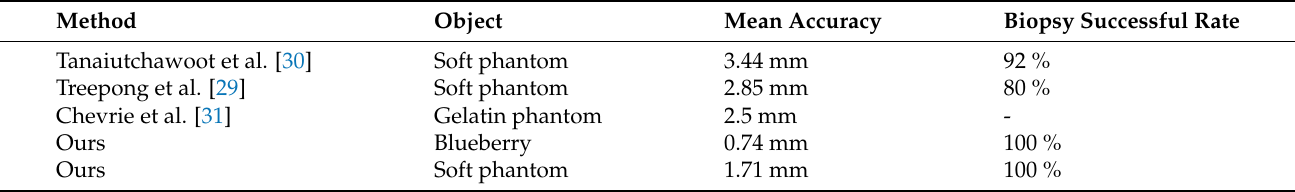
Table 7. Comparison with other SOTA biopsy methods. “-” indicates that the corresponding data are not